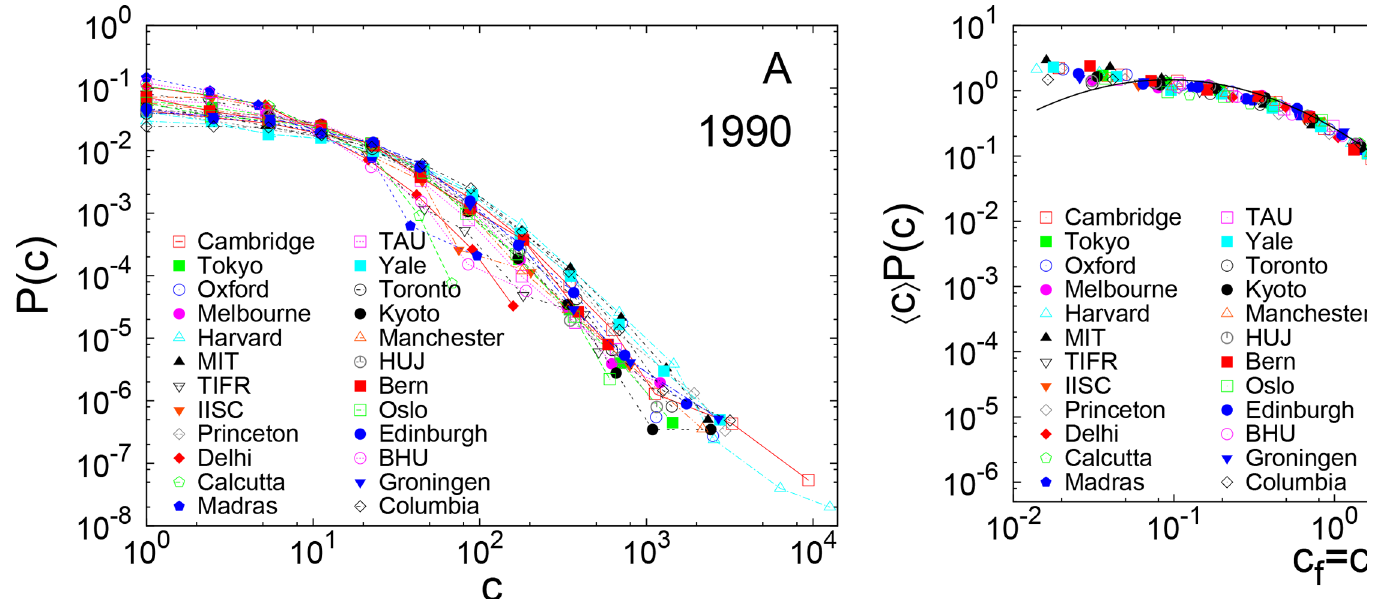
Fig 1. Probability distribution of citation for academic institutions for 1990 (unscaled and rescaled). (A) Probability distribution P (c) of citations c to publications from 1990 for several academic institutions. (B) The same data rescaled by average number of citations h c i . The data for different institutions seem to follow the same scaling function. It fits very well to a lognormal function for most of its range, with μ = − 0.73 ± 0.02, σ = 1.29 ± 0.02. The largest citations do not follow the lognormal behavior, and seem to follow a power law: c − α , with α = 2.8 ± 0.2.